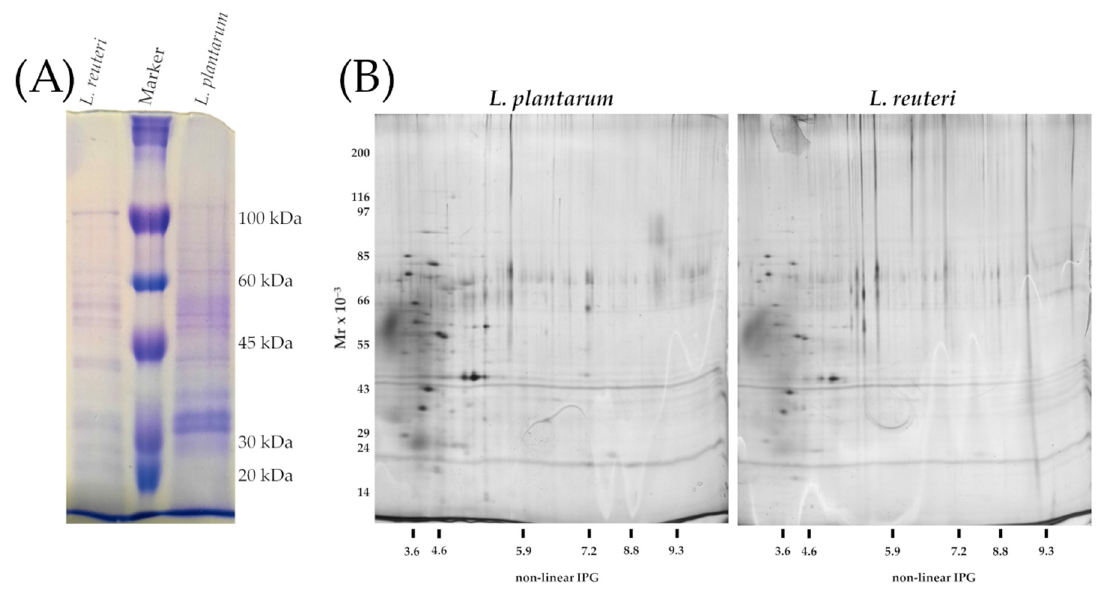
Figure 6. ( A ) SDS-PAGE of surface proteins. Equal amount of volume (14 µL) of the extracted polypeptides were loaded to each well; from left to right: S-layer extracted from Lactobacillus reuteri ; Molecular weight marker (kDa), S-layer extracted from Lactobacillus plantarum. ( B ) Two-dimensional gel electrophoresis of S-layer polypeptides extracted from L. plantarum and L. reuteri .